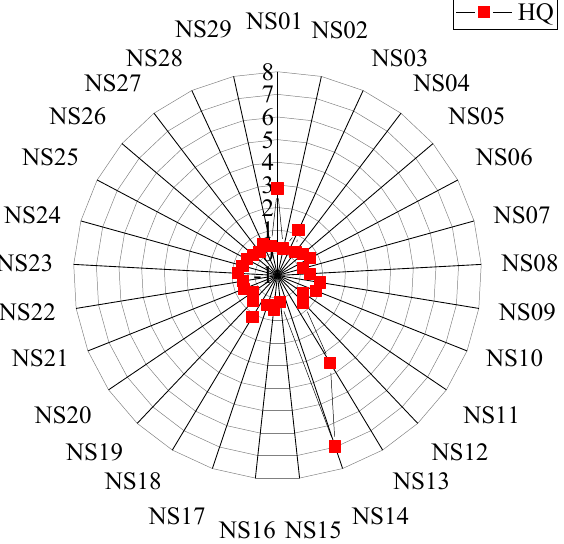
Figure 4. The HQs’ distribution of carbamazepine in Nansi Lake basin.